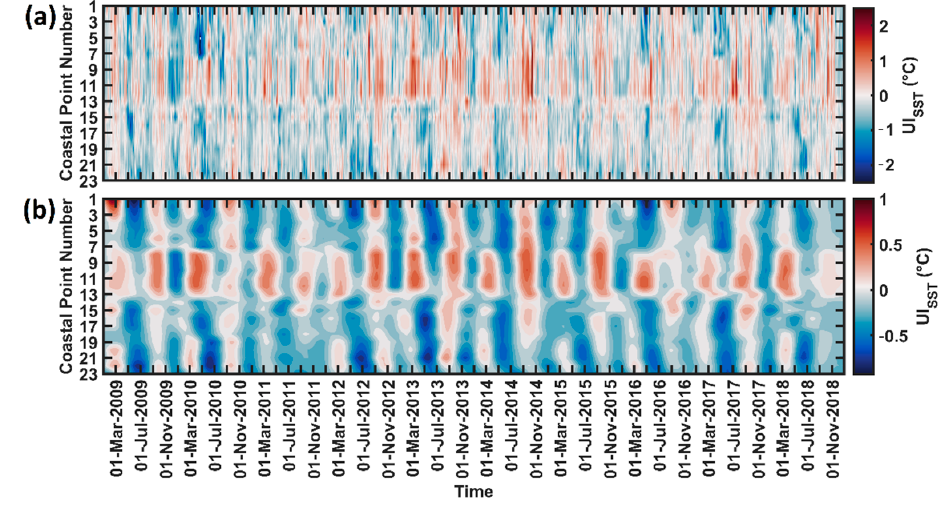
Figure 5. Temporal variation of ( a ) unfiltered and ( b ) filtered SST-based UI (UI SST ) along the eastern coastline of India.